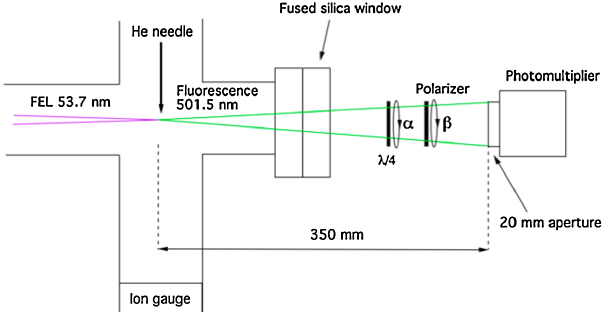
FIG. 7. Schematic diagram of the experimental apparatus for the polarization measurements at